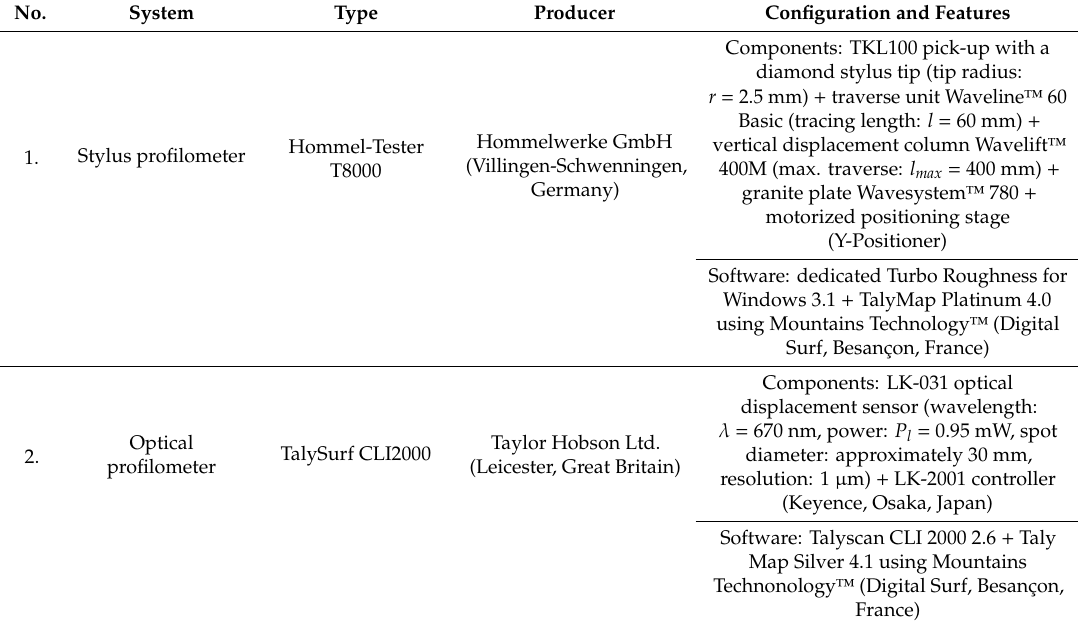
Table 7. Characteristics of observation measurement systems used in the experimental